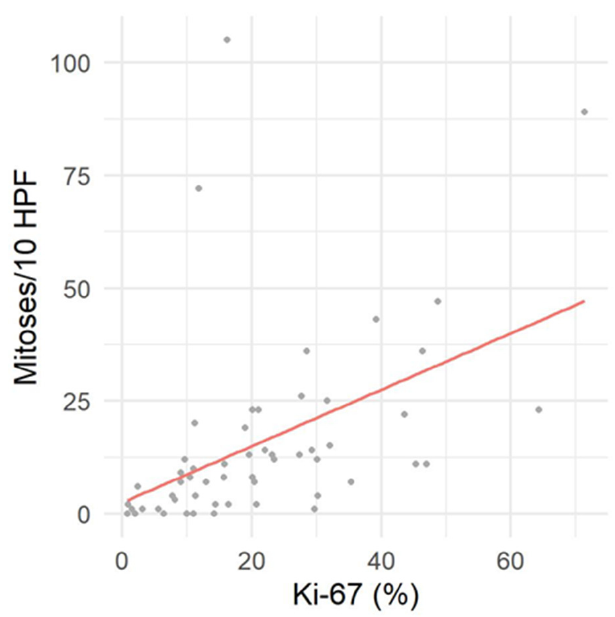
Figure 7. Correlation between proliferation index Ki-67 and mitotic count per 10 high power fields (HPF). Table 4. Tumor types and results of immunohistochemical stainings for each examined case.